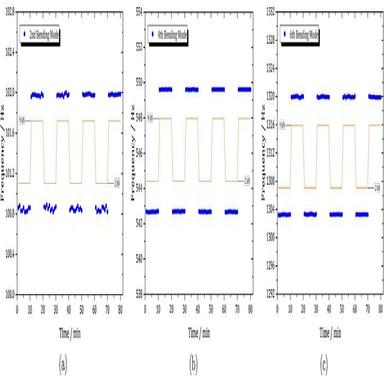
Metglas ribbons repeatability graphs versus time and applied load, for the (a) 2nd, (b) 4th and (c) 6th bending modes of the cantilever beam.